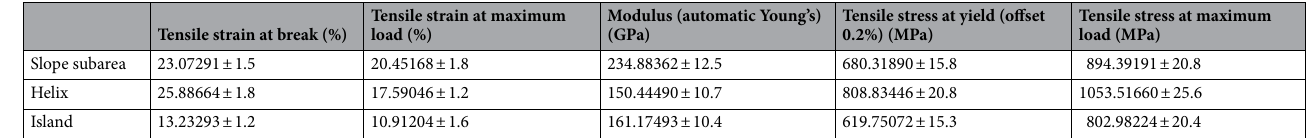
Table 4. Tensile parameter of samples under different scanning strategies.